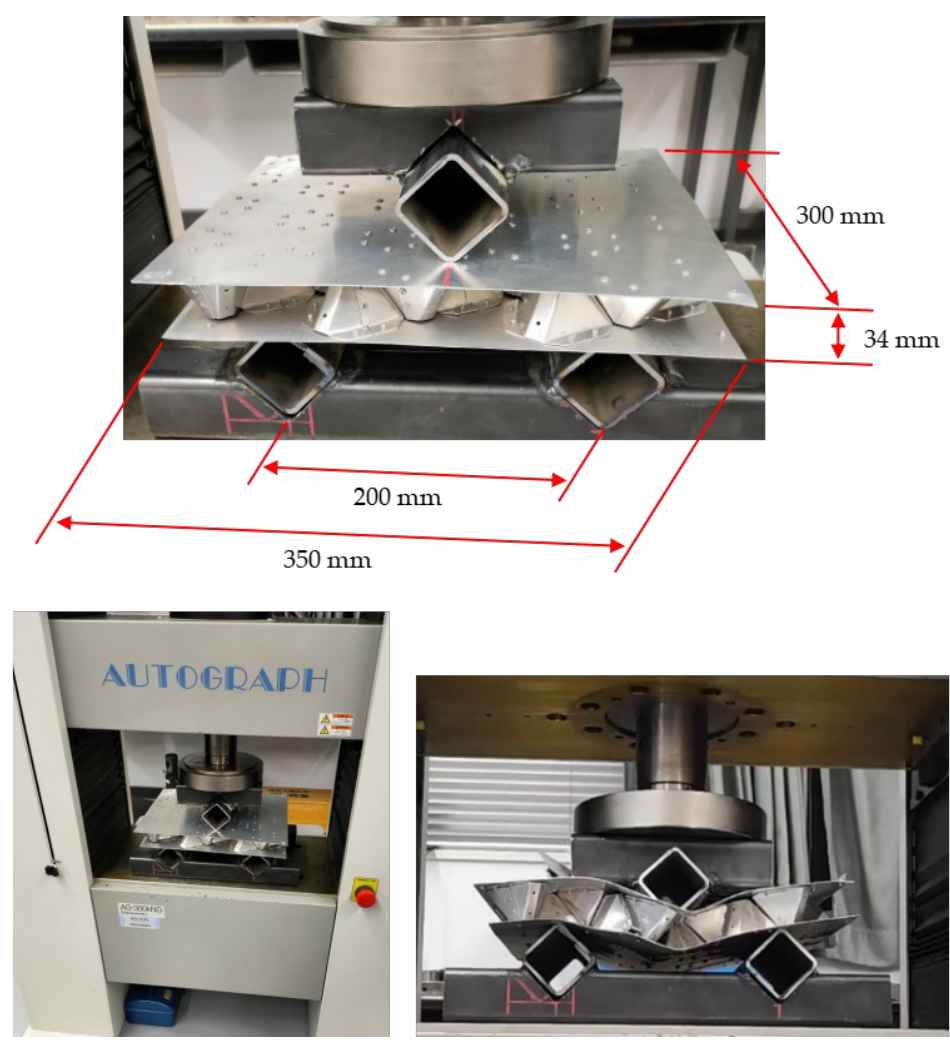
Figure 11. Three-point bending test to examine mechanical properties of assembled truss core